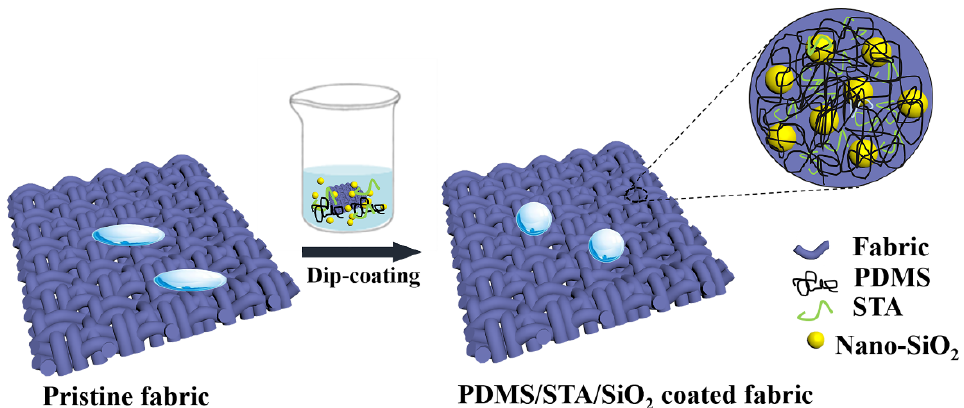
Scheme 1. Fabrication scheme of the superhydrophobic coating on the